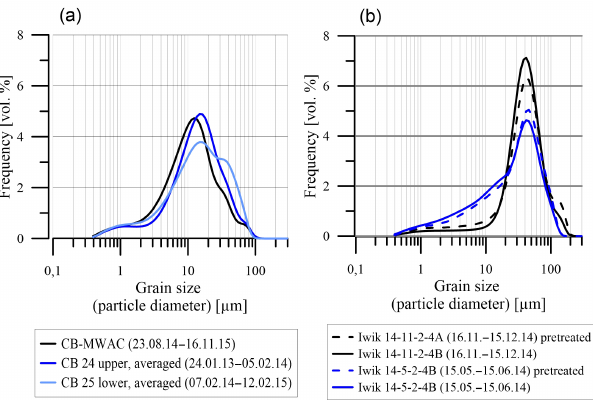
Figure 3. (a) Grain-size distributions for the station CB: dust sam- pled with the MWAC sampler 2ma.s.l., with the upper sediment trap 1214mb.s.l. and the lower trap 3622mb.s.l. (b) Grain-size dis- tributions of samples of the Iwik 14 time series which have been pretreated with HCl, H 2 O 2 and NaOH (dotted lines) and without pretreatment